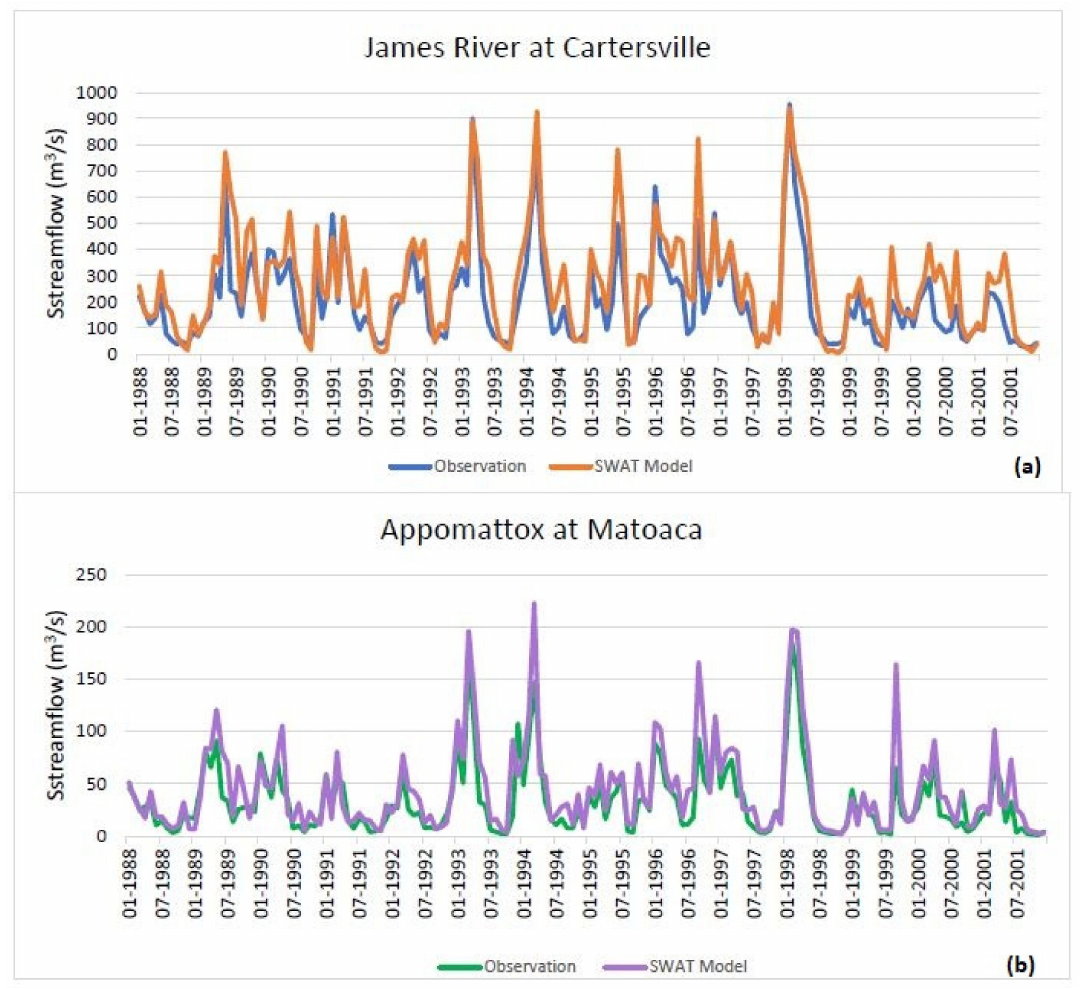
Figure 2. Trend comparison of flow in m 3 /s for the James River at Cartersville ( a ), and the Appomattox at Matoaca ( b ), using observed vs. modeled data.